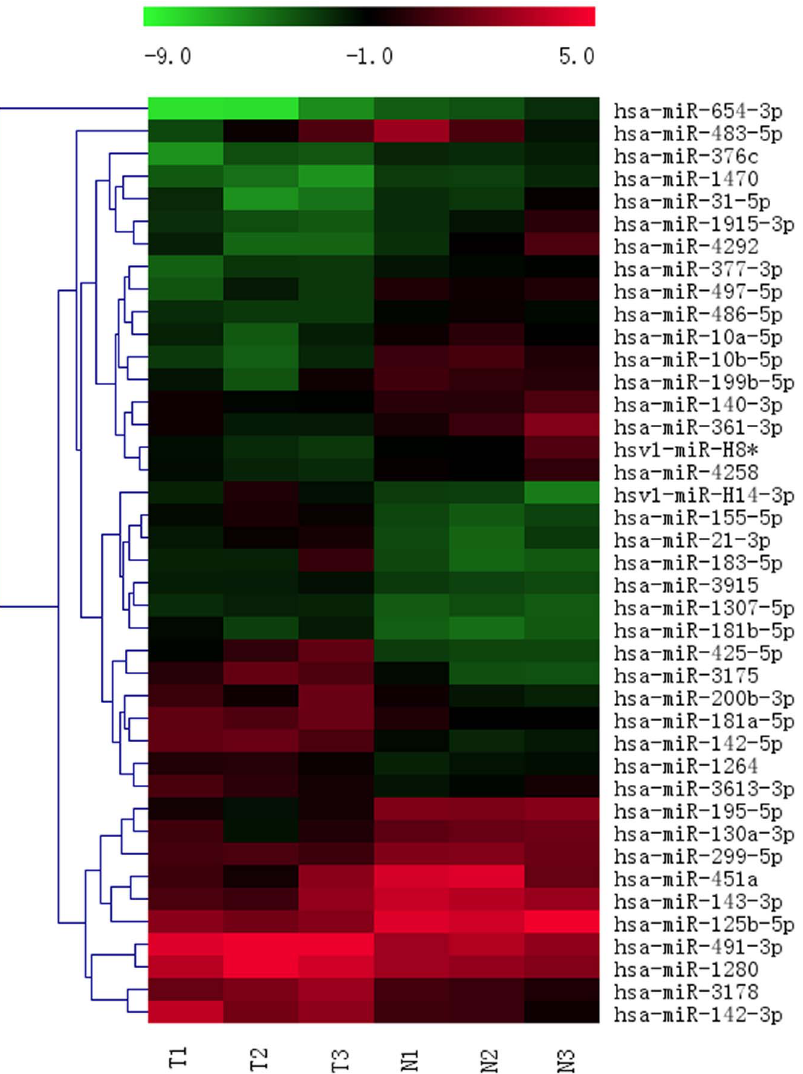
Figure 2. miRNA differential expression in TNBC versus normal breast tissues. Hierarchical clustering of the 41 miRNAs with a significantly different expression. Rows, individual miRNAs; columns, individual tissue samples. Pseudocolors represent transcript levels above, equal to, and below the mean (red, black, and green, respectively). The scale represents the intensity of miRNA expression (log2 scale ranges between 2 9 and 5).